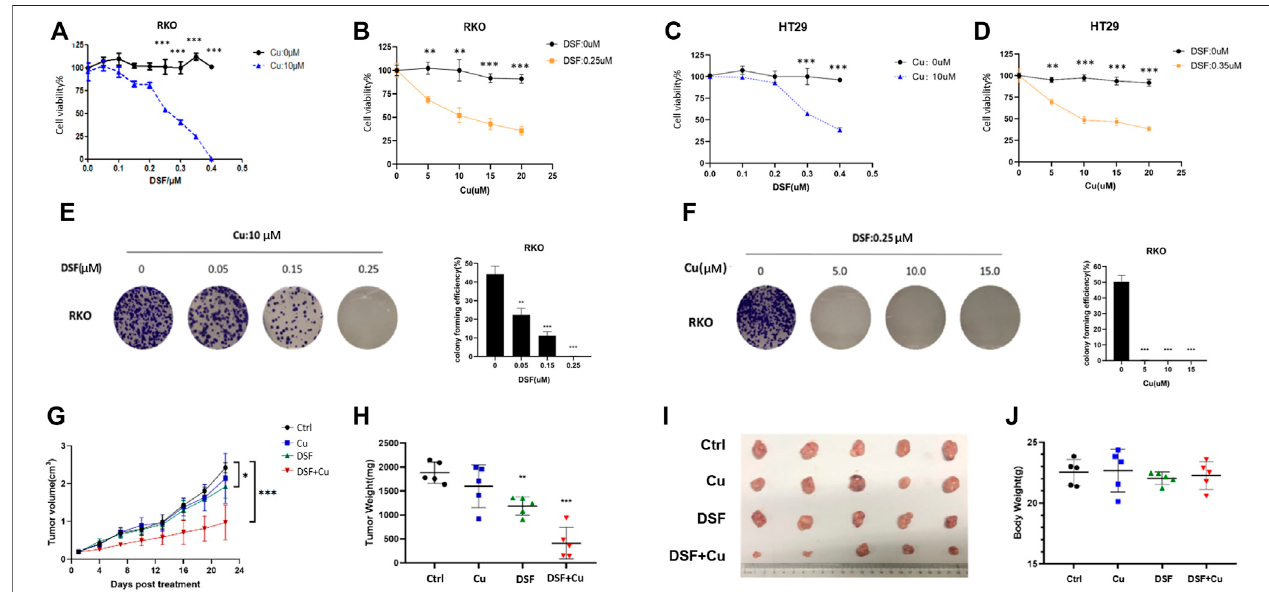
FIGURE 1 | DSF/Cu inhibits CRC cell viability in vitro and in vivo . (A – D) The colorectal cancer cell lines RKO and HT29 were treated with different concentrations of DSF/Cu (DSF: 0.1 – 0.4 μ M; Cu: 5 – 10 μ M) for 48 h, and cell viability was evaluated by CCK8 assay. The IC50 values of DSF were 0.25 and 0.3 μ M for RKO and HT29 cells, respectively. (E) Colorectal cancer cell line RKO was treated with different concentrations of DSF (0.05 – 0.25 μ M) and a fi xed Cu concentration (10 μ M), after which inhibition effects were determined by colony formation assay. (F) Colorectal cancer cell line RKO was treated with different concentrations of Cu (5 – 15 μ M) and a fi xed DSF concentration (0.25 μ M) after which inhibition effects were determined by colony formation assay. (G) The growth curves of tumors in mice treated by the indicated drugs. (H) Xenografts extracted from mice at day 22. The tumors by the data are shown as means ± SD. *** p